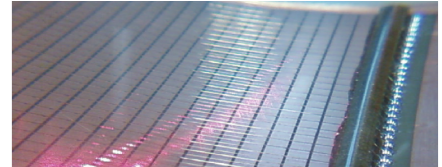
Figure 3: Photo of the inner pad and wire structure of a Close Cathode